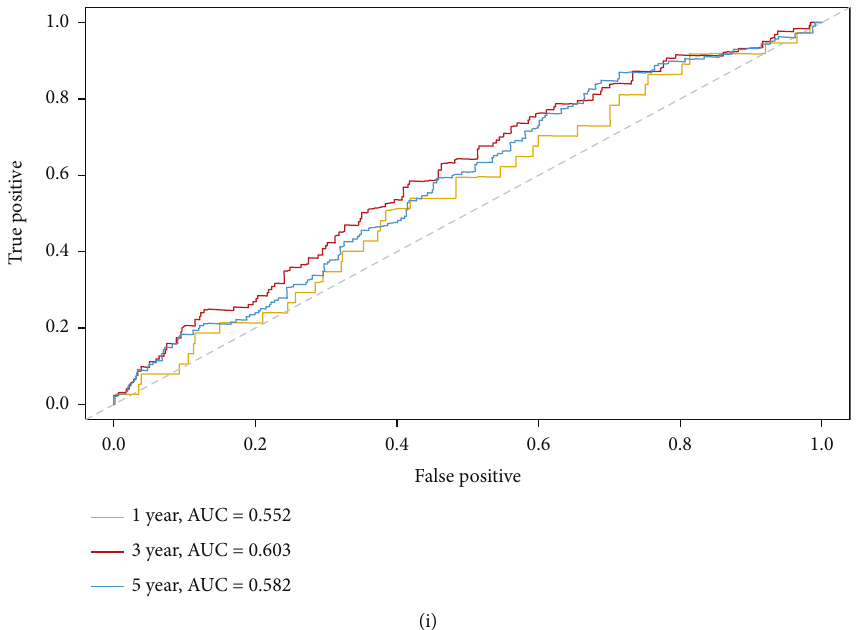
Figure 5: ISS as a predictor of patient prognosis in the validation cohorts: (a) distribution of high- and low-ISS groups in the GSE17536 cohort; (b) comparison of patient prognosis between the high- and low-ISS groups of the GSE17536 cohort; (c) ROC curve for ISS in the GSE17536 cohort; (d) distribution of the high- and low-ISS groups in the GSE38832 cohort; (e) comparison of patient prognosis in the high- and low-ISS groups of the GSE38832 cohort; (f) ROC curve for ISS in the GSE38832 cohort; (g) distribution of the high- and low- ISS groups in the GSE39582 cohort; (h) comparison of patient prognosis between the high- and low-ISS groups of the GSE39582 cohort; (i) ROC curve for ISS in the GSE39582